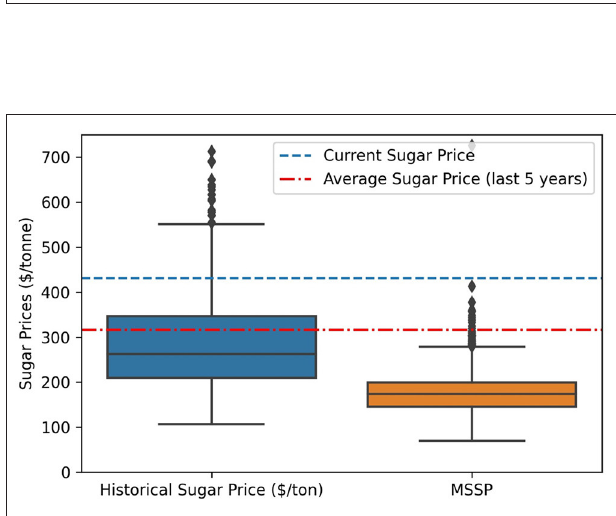
FIGURE 6 | Boxplot comparison of the historical sugar prices (Left) and Generative Adversarial Network (GAN) Minimum Sugar Selling Price (MSSP) estimates (Right) .